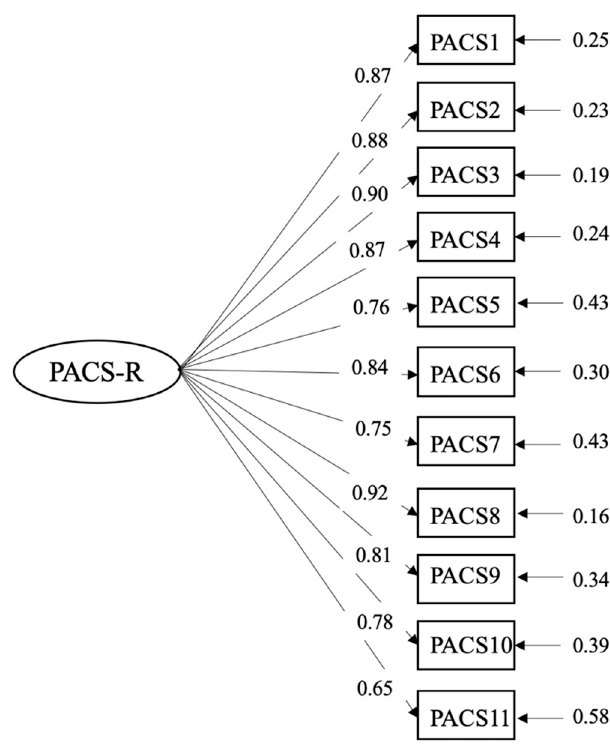
Figure 1. Path diagram and factor loadings of the Physical Appearance Comparison Scale-Revised (PACS-R).